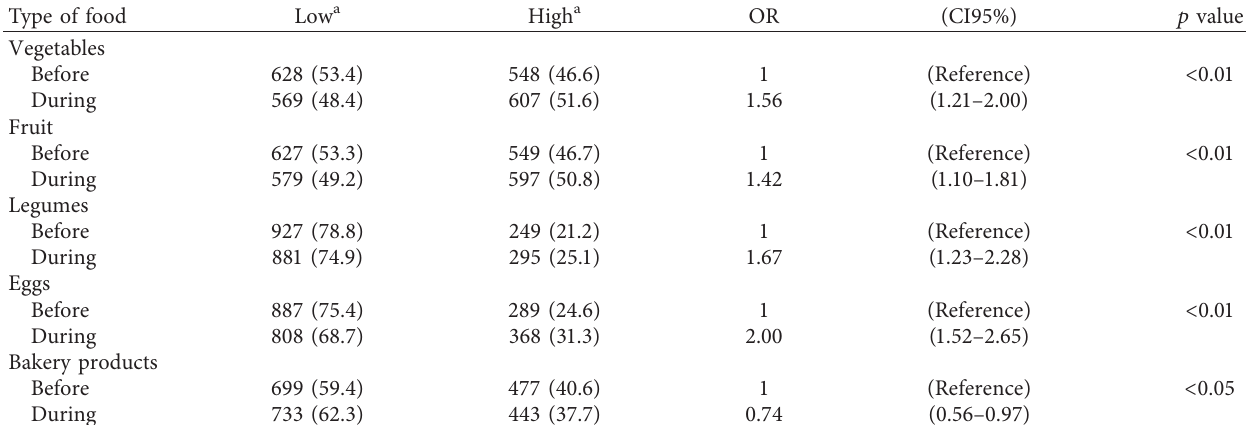
Table 3: Changes in consumption of food before and during social